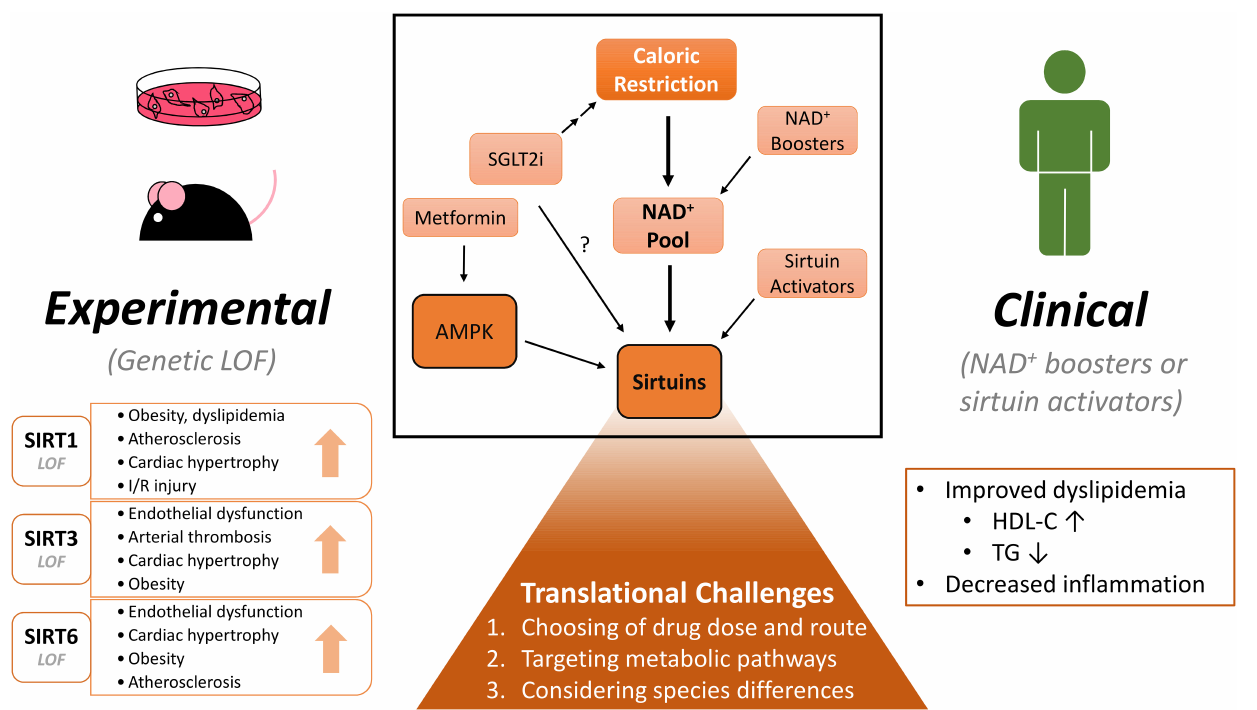
FIGURE 1 | Experimental and clinical benefits of modulating NAD + pool and sirtuins on cardiovascular diseases. CR (Caloric restriction) and NAD + (nicotinamide adenine dinucleotide) boosters raise the NAD + pool within the cell and in turn may activate sirtuins. Similar effects may be induced by pharmacological sirtuin activators. Activation of sirtuins confer numerous beneficial effects: In experimental rodent models, sirtuin isoform loss-of-function studies demonstrate deterioration in cardiometabolic diseases. NAD + boosting also shows some benefits in clinical studies, but more diligent study designs are warranted. When considering clinical translation, several challenges will need to be addressed to determine the clinical potential of these molecules. Lastly, SGLT2 (sodium glucose cotransporter 2) inhibitors show protection in cardiovascular disease. By inducing a state of caloric restriction, they may modulate the NAD + pool and/or sirtuin activity. Many drugs may have unspecific effects, which are not highlighted in this figure. LOF, loss-of-function; I/R, ischemia-reperfusion; NAD + , nicotinamide adenine dinucleotide; SGLT2i, sodium-glucose cotransporter 2 inhibitor; HDL-C, high-density lipoprotein cholesterol; TG, triglyceride.